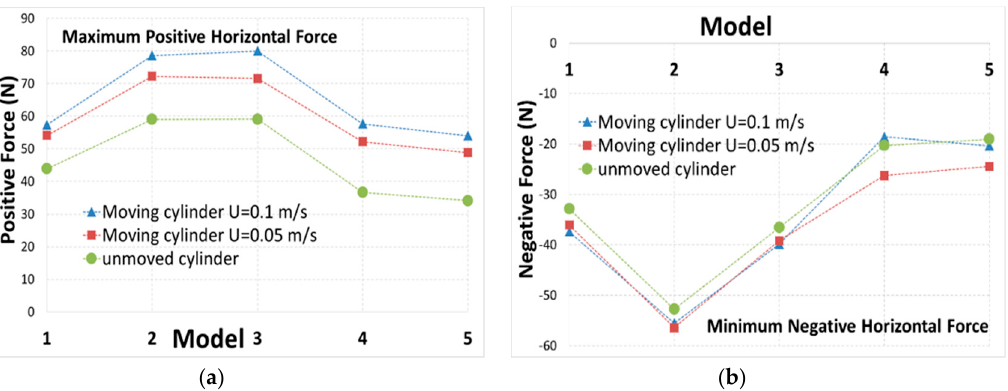
Figure 13. Positive and negative peaks of the horizontal forces for all models. ( a ) The positive force; ( b ) the negative force. Table 3. The time occurrences of the peaks of the horizontal forces.